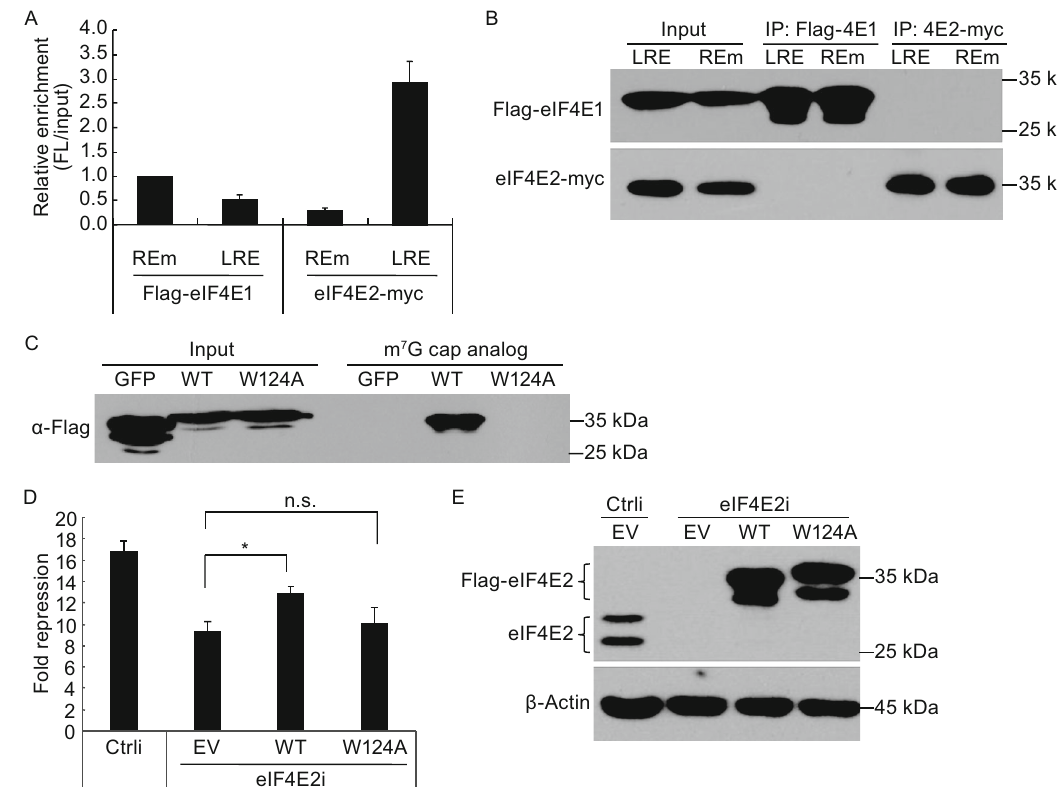
Figure 6. MiRNA silencing increases eIF4E2 association with target mRNA. (A and B) HEK293 cells were transfected with plasmids expressing Flag-tagged eIF4E1, myc-tagged eIF4E2, Let-7a, and reporter pLRE-fLuc or pREm-fLuc. The reporter phRL- CMV was included to serve as a control for transfection ef fi ciency and sample handling. At 48 h postinfection, cells were lysed. (A) The cell lysate was immunoprecipitated with the anti-Flag or anti-myc af fi nity gel. Reporter mRNA levels were measured by RT- qPCR. The fLuc mRNA levels were normalized with the RL mRNA levels. Relative enrichment was calculated as the amount of the reporter mRNA in the precipitates divided by that in the input cell lysate. The relative enrichment of fLuc-REm mRNA by eIF4E1 was set as 1. Data presented are means ± SD of two independent experiments. (B) The cell lysate and the remaining precipitates were resolved on SDS-PAGE followed by Western blotting. (C) Flag-tagged GFP, eIF4E2 or its mutant eIF4E2-W124A was transiently expressed in HEK293T cells and pulled down with beads conjugated to the cap analog M7-GTP. The cell lysates and precipitates were analyzed by Western blotting. (D and E) HeLa cells were transfected with plasmids expressing the shRNA targeting eIF4E2, pLRE-fLuc or pREm-fLuc reporter and a renilla luciferase-expressing control reporter, and a rescue plasmid expressing the wild-type or mutant eIF4E2. At 48 h postinfection, cells were lysed. (D) Luciferase activities were measured. Fire fl y luciferase activity was normalized with the renilla luciferase activity. Fold repression was calculated as the normalized luciferase activity expressed from pREm-fLuc divided by that from pLRE-fLuc. Data presented are means ± SD of three independent experiments. The P value is determined by two-tailed Student ’ s t test. ns, nonsigni fi cant. * P < 0.05. (E) A fraction of the cell lysate was subjected to SDS-PAGE followed by Western